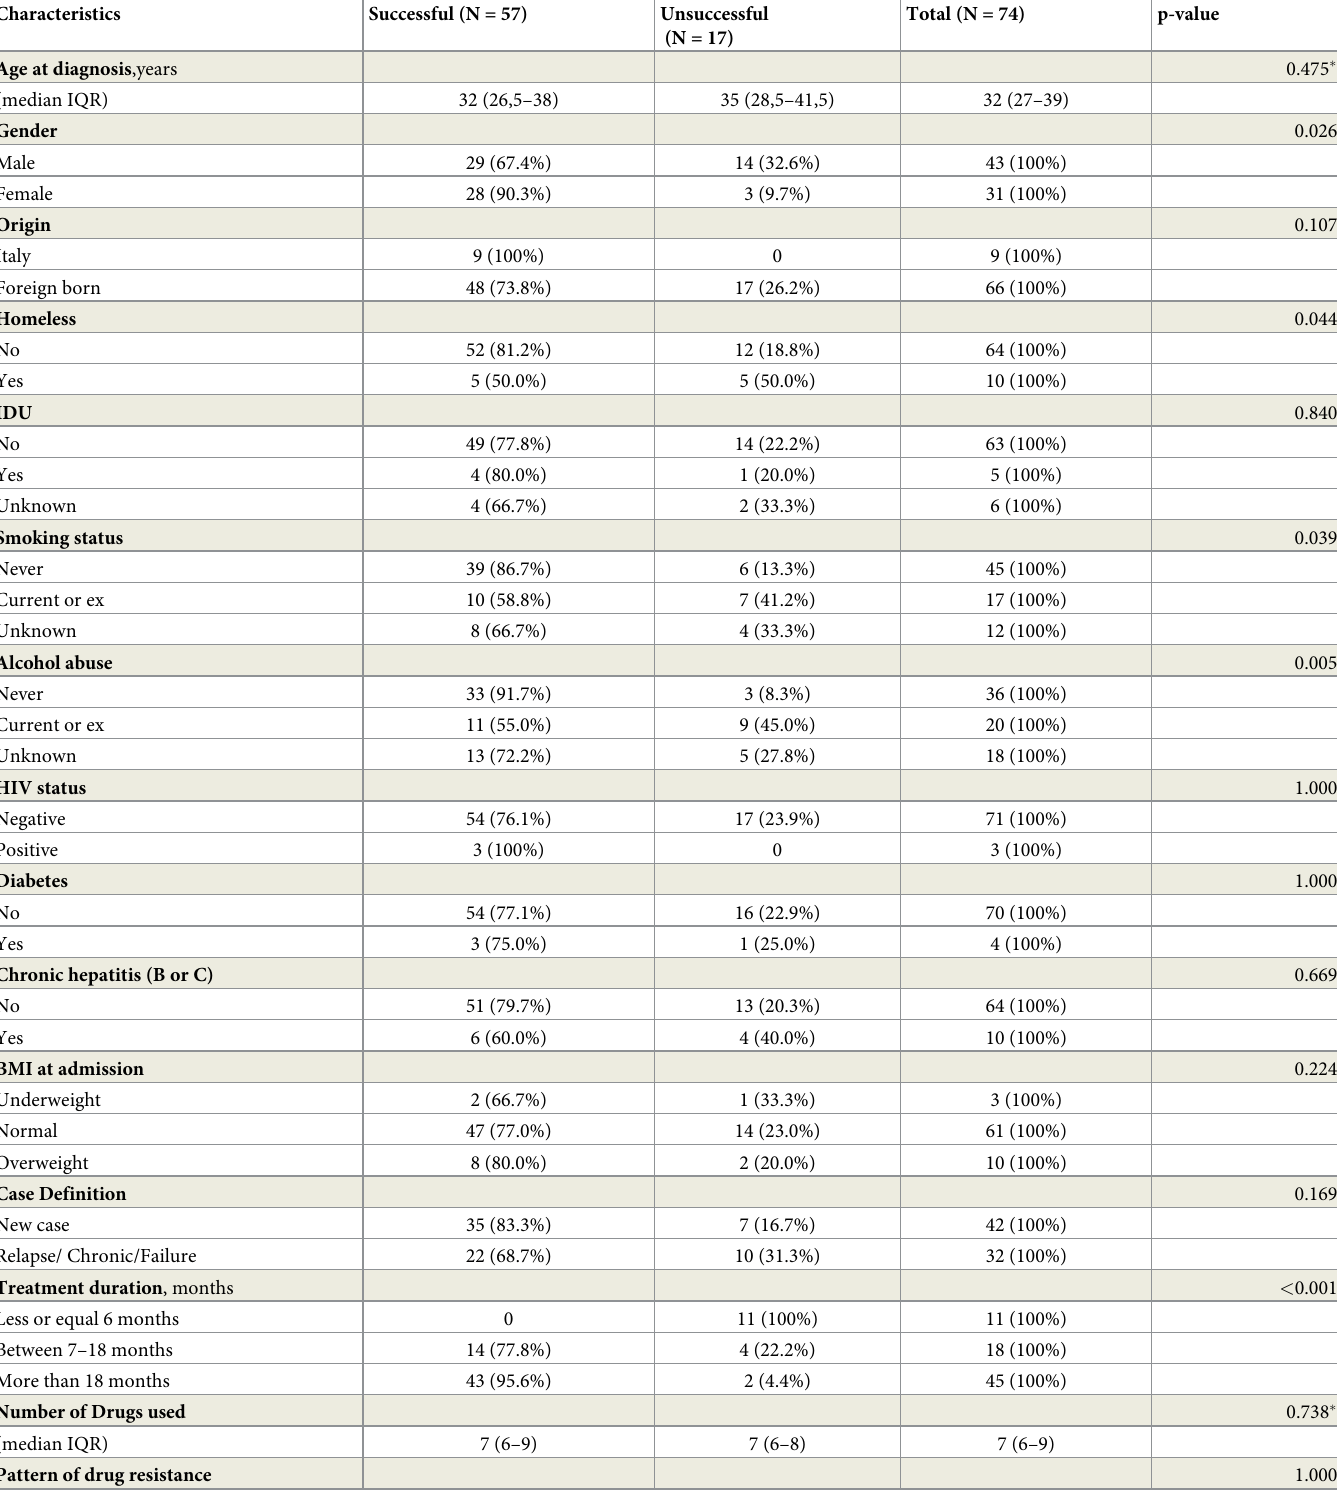
Table 3. Characteristics of 74 patients: 57 successful vs 17 unsuccessful